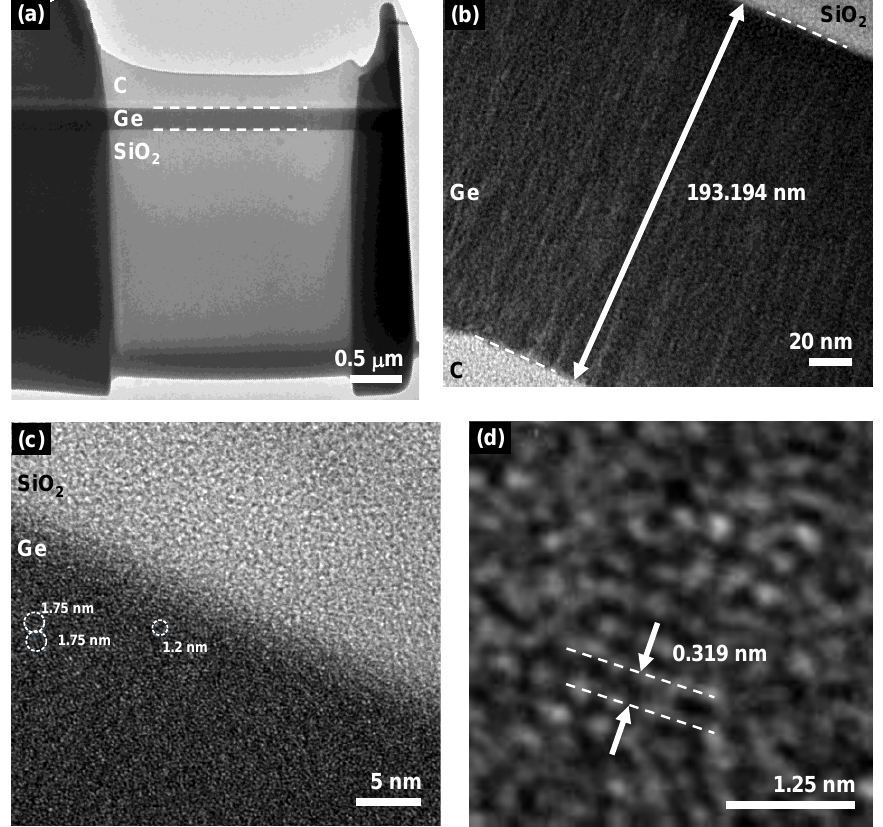
Figure 5. ( a – c ) TEM images of the PECVD-grown Ge thin-film at different positions. ( d ) The high- resolution TEM image of the PECVD-grown Ge thin-film.